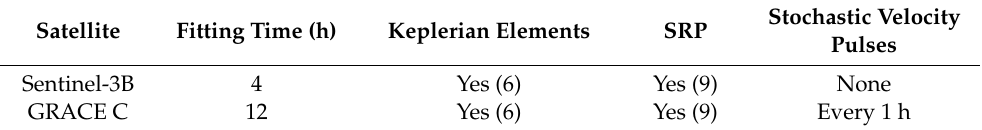
Table 2. Prediction strategies of the LEO satellites Sentinel-3B of about 810 km and GRACE C of about 500 km orbital heights above